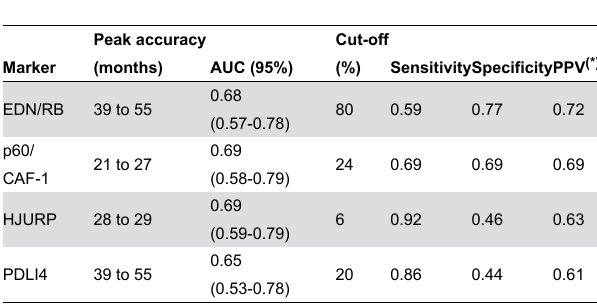
Table 2. Prognostic accuracy of the four markers by time- dependent ROC curve